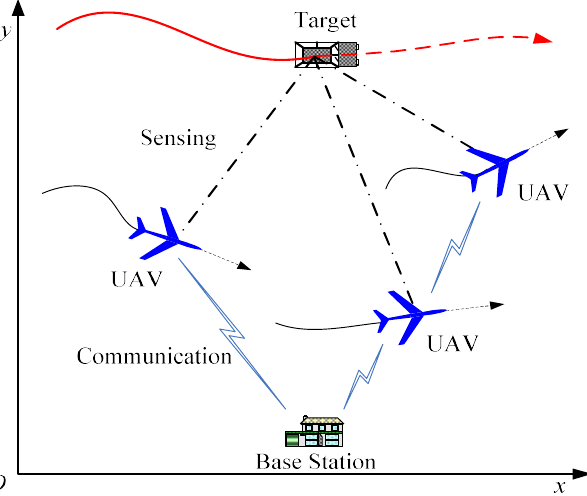
Figure 1. The scenario where a fixed base station utilizes multi-UAVs for tracking a ground moving target.